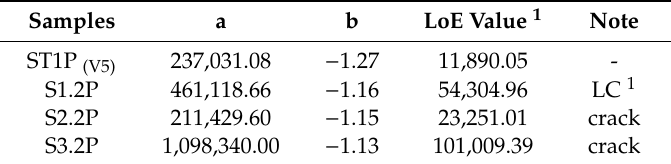
Table 5. Values of the coe ffi cient ( a ) and power ( b ) in the best fit power laws reported in Figure 9 and of the theoretical locus of equilibrium (LoE) (see below for the four types of tested pine samples, i.e., ST1P (uncoated, red dots and lines), S1.2P (Renaissance Wax, black dots and lines), S2.2P (CS + Paraloid, blue dots and lines), and S3.2P (tar, green dots and lines). Damage and undamaged or low and high constraint notes are also